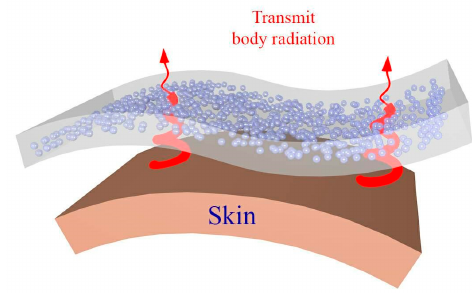
Figure 1. Schematic representation of the SiO 2 particles embedded in a polyethylene (PE) membrane, designed for radiative indoor heating. The transmitted thermal radiation from the human body is a ff ected by the SiO 2 particle absorption.